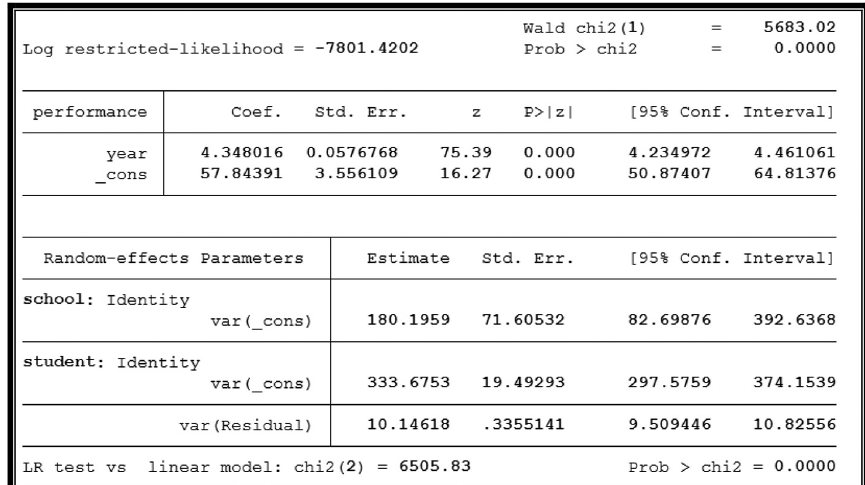
Figure 6. Linear trend model with random